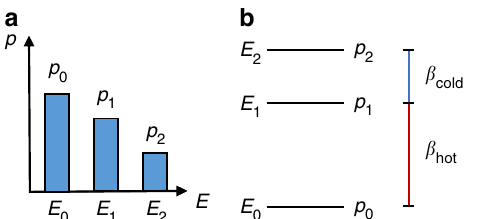
Fig. 1 Passive state spectrum and virtual temperatures. a The spectrum of a P 2 p i i j i i h j over the eigenbasis of its Hamiltonian qutrit passive state ρ ¼ P i ¼ 0 2 H ¼ E i i j i i h j . The occupation probabilities are ordered in a decreasing i ¼ 0 order, from the one associated with the ground state of H to the one associated with the maximally excited one, as per de fi nition in Eq. (2). b A passive state can equally be described by virtual temperatures. Indeed, for each pair of eigenvalues of ρ , say p i and p j , we can de fi ne a virtual temperature β ij through the relation p i = p j ¼ e (cid:2) β ij E i (cid:2) E j ð Þ , where E i ( E j ) is the energy level associated with the eigenstate i j i j j ið Þ . In the fi gure, the pair of eigenstates 0 j i and 1 j i is associated with the hot temperature β (cid:2) 1 , while the pair 1 j i and 2 j i is hot associated with the cold temperature β (cid:2) 1 . The temperature associated with cold 0 j i and 2 j i is an average of the other